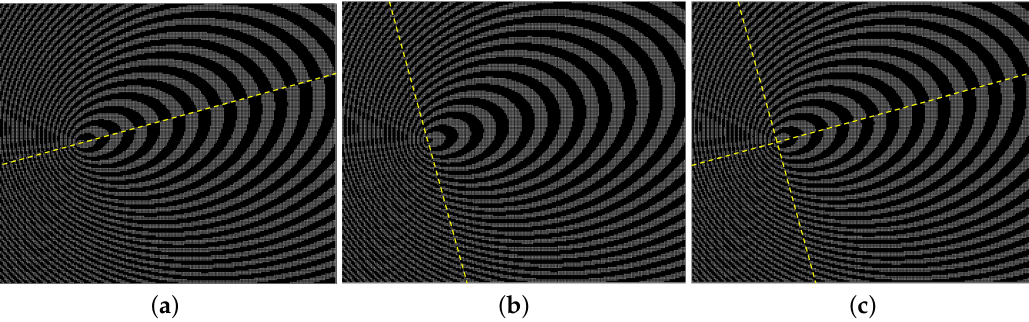
Figure 11. The holographic pattern of the surface-reactance profile needed to form a pencil beam with ( a ) horizontal, ( b ) vertical, and ( c ) circular